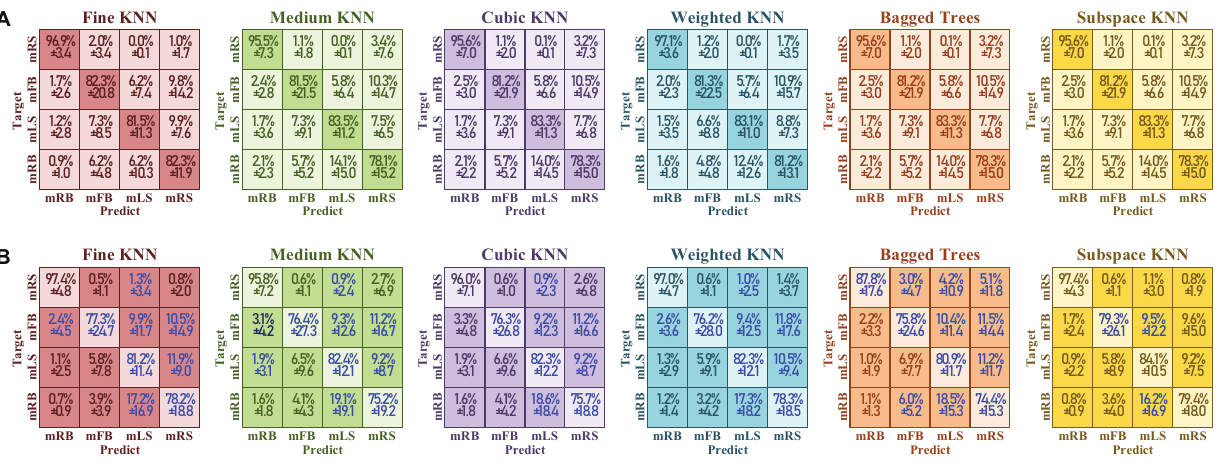
makes the EEG tend to show different feature distribution with time-shifting. In other words, the feature space or data distribution extracted under partial time has poor